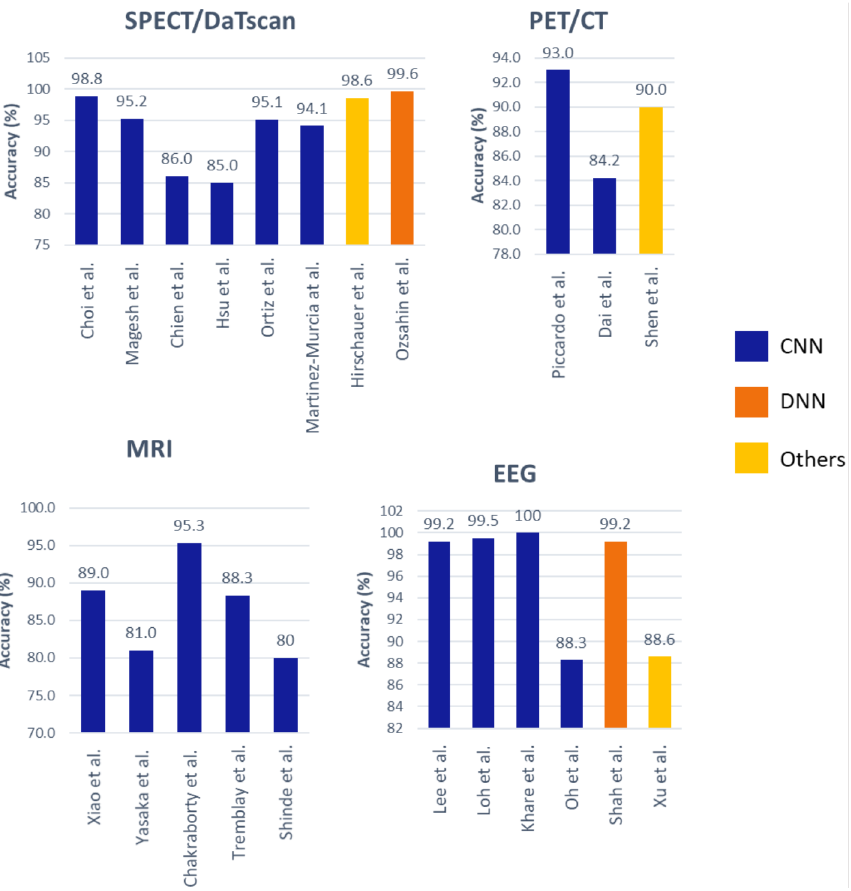
Figure 7. Bar plot representation of the model accuracy by various investigators for different modalities of brain